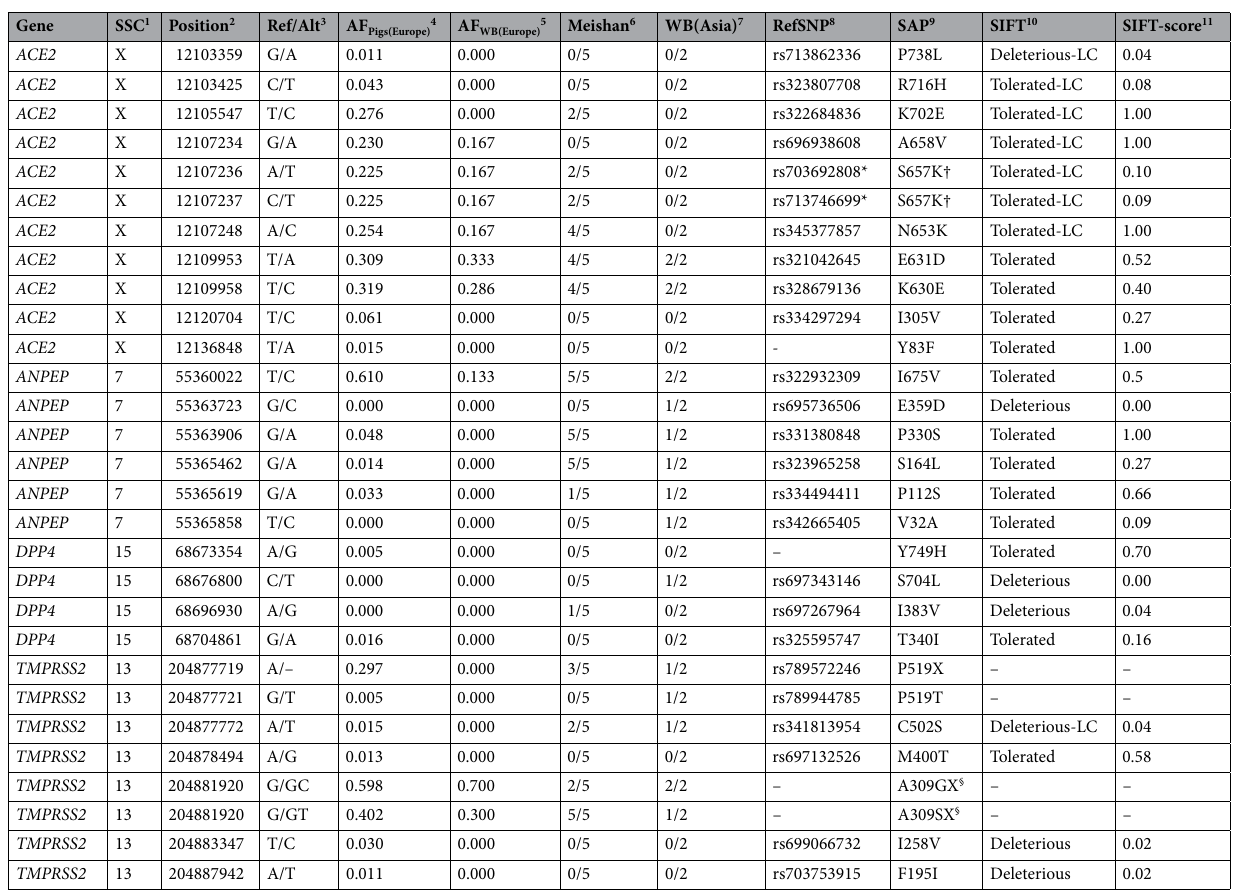
Table 2. Protein coding variants identified in the European and Asian pig breeds and wild boars. 1 Sus